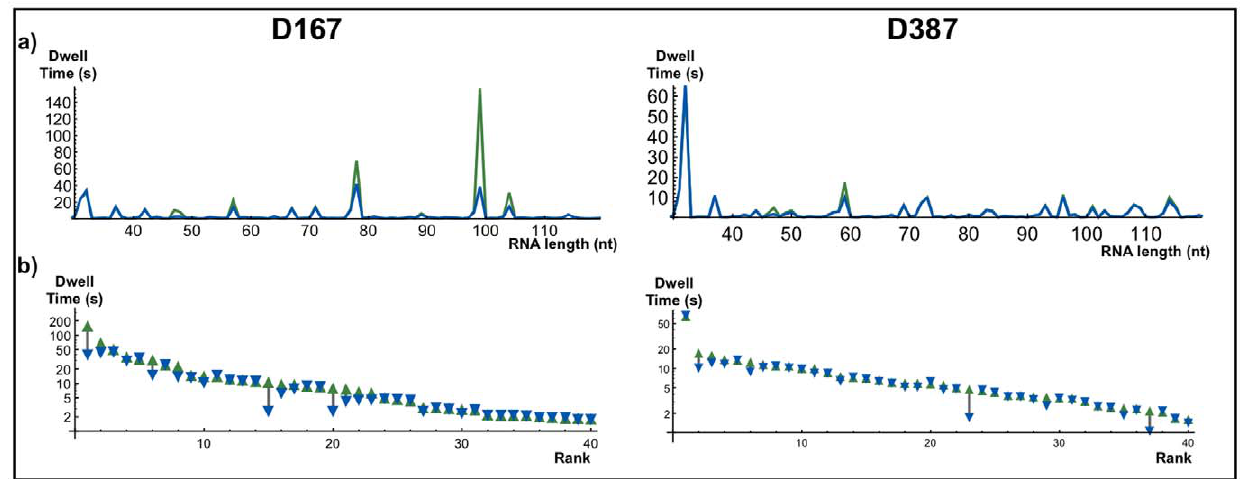
Figure 6. Elongation kinetics for sequences D167 and D387: a) Dwell times between nucleotide incorporation by the RNA strand length. Green: SRA ; Blue: MRA . The lines are almost overlapped: differences between them arise only in sites with larger dwell times. b) Forty larger values of dwell time for SRA (upward triangle, green) and the value for the correspondent site in MRA (downward triangle, blue). The graph is on a logarithmic scale.